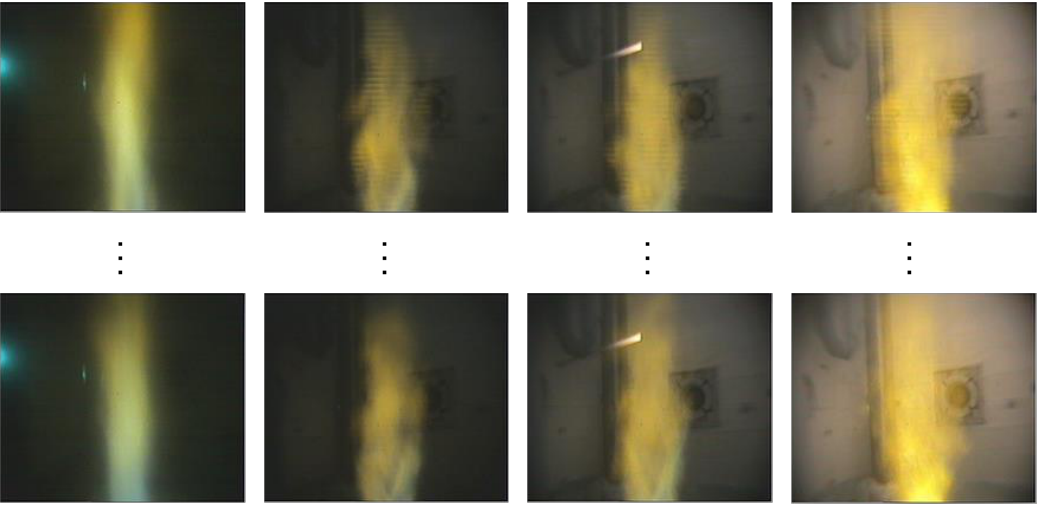
Figure 9. Flame images of four cases (60 frames / 5 min).